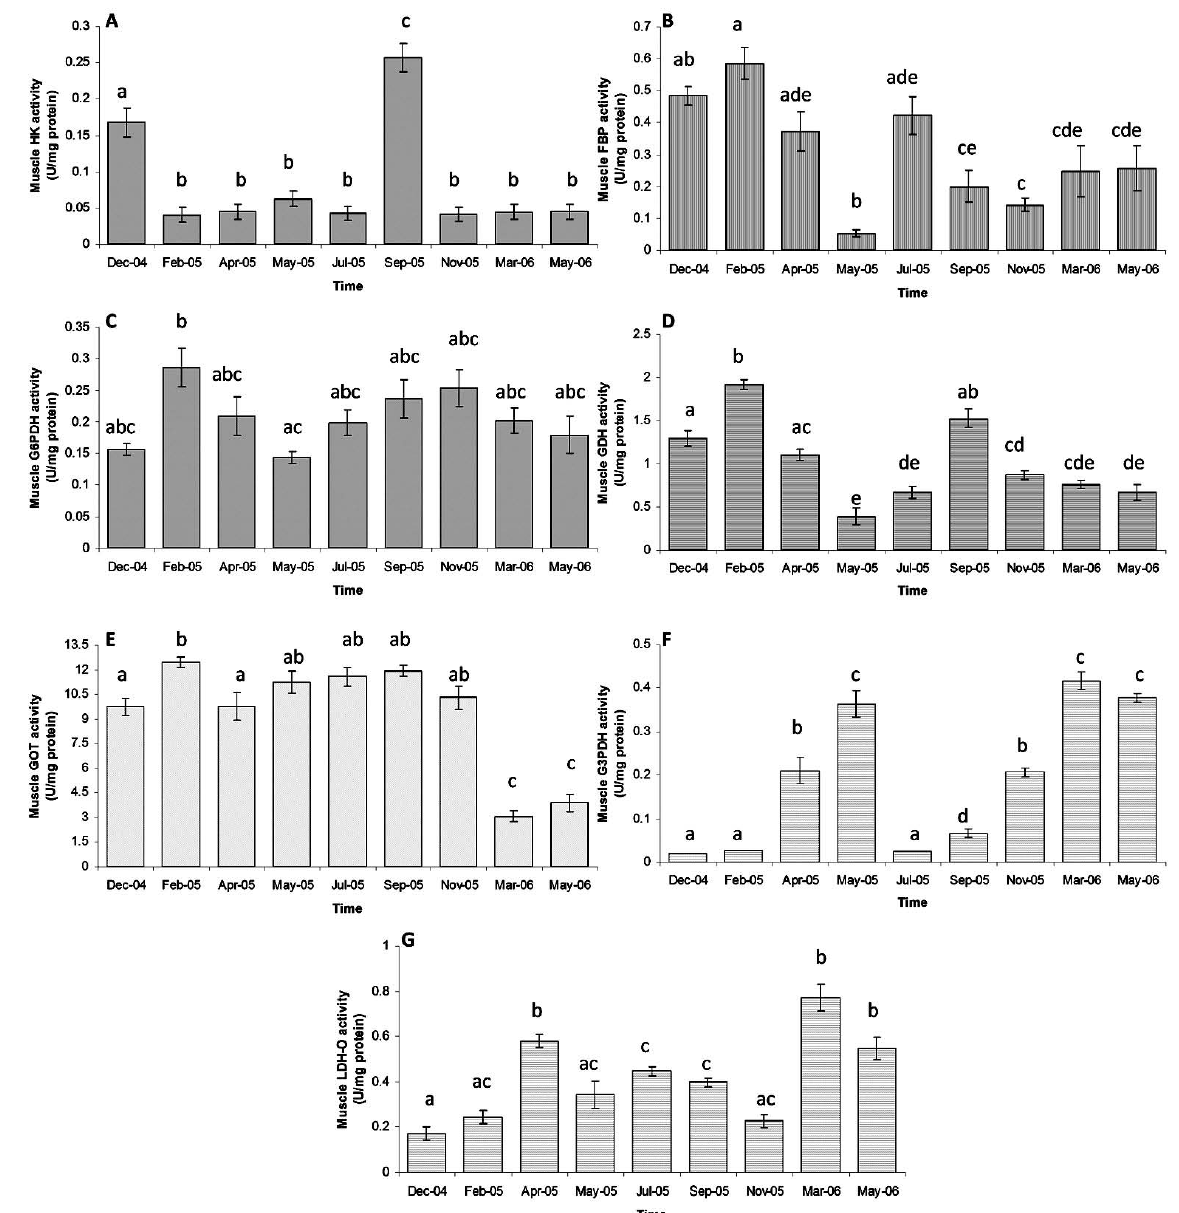
Fig. 4. – Seasonal changes in muscle HK (A), FBP (B), G6PDH (C), GDH (D), GOT (E), G3PDH (F) and LDH-O (G) activities in A. regius specimens cultured in earthen ponds. Further details as in legend of Figure